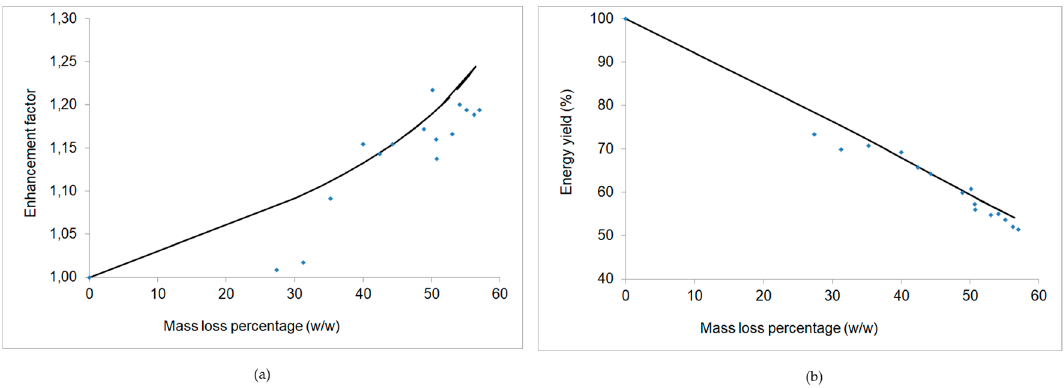
Figure 7. Torrefied barley straw ( a ) Enhancement Factor (EF) and ( b ) Energy yield (EY) vs. the mass loss percentage.